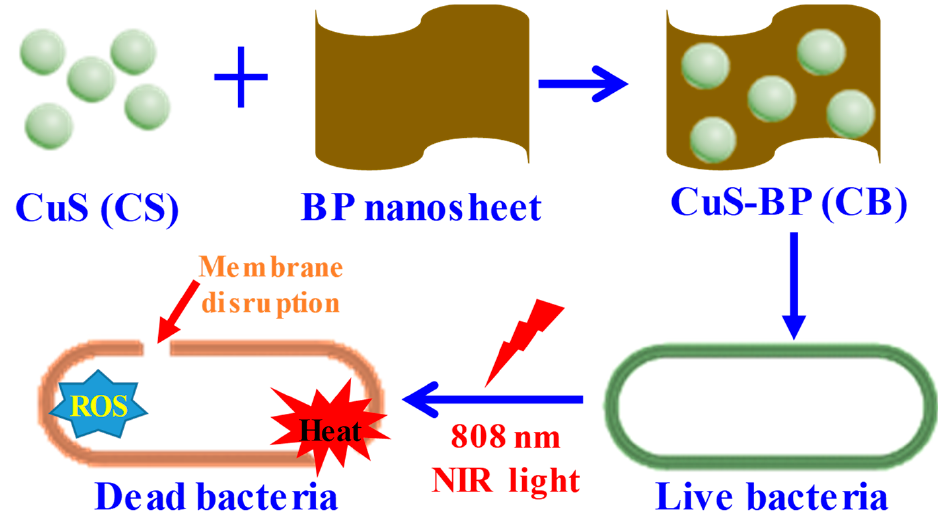
Figure 3. Schematic of CuS-BP synthesis and its PTT- and PDT-dependent antibacterial activity. Reproduced with permission from Ref. [47]. Copyright 2022 Elsevier.